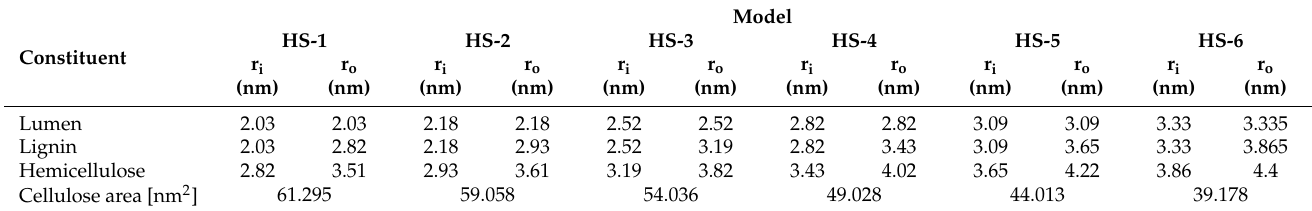
Table 4. Geometrical details of the Hierarchical Structure for FE Models.